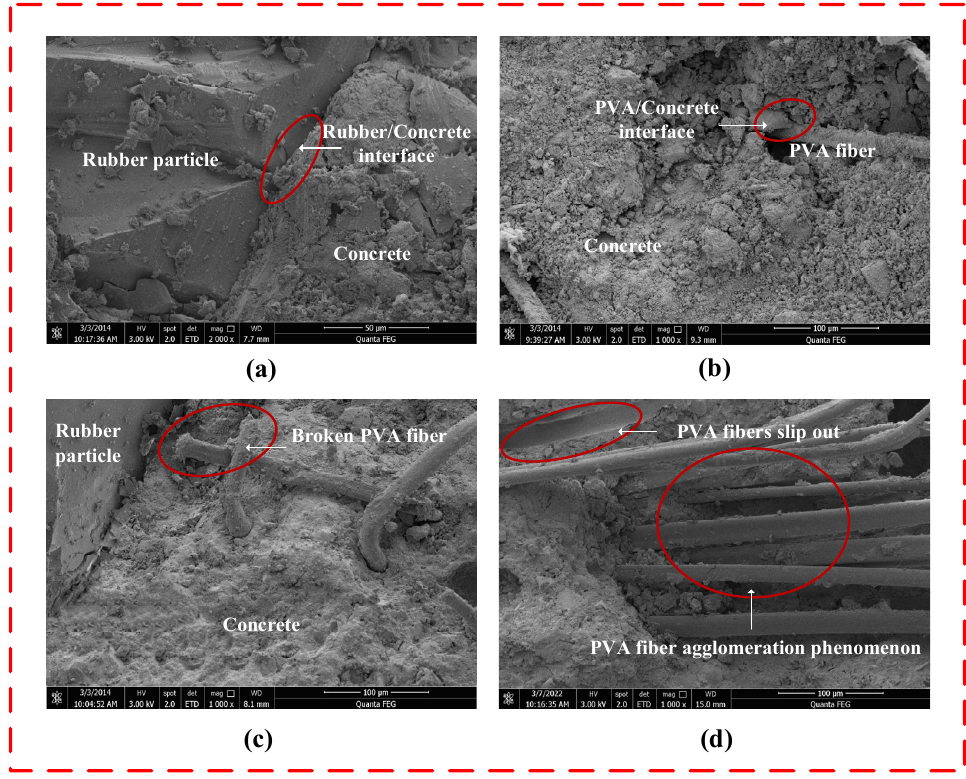
Figure 9. Micromorphology of the specimen: ( a ) Rubber concrete; ( b ) PVA rubber/concrete; ( c ) PVA destruction form; ( d ) PVA aggregation phenomenon.